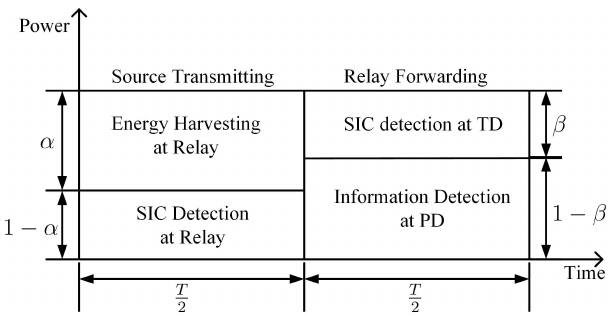
Figure 2. Illustration of transmission